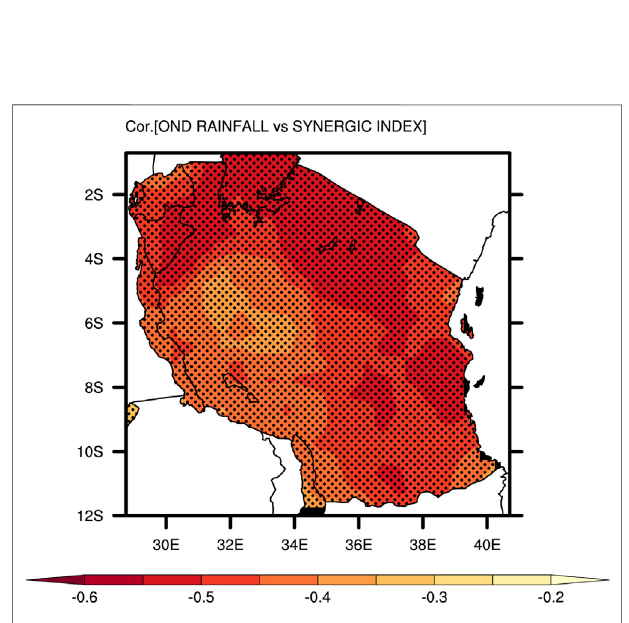
FIGURE 14 | Schematic summary of the process for the impact of warm EA-SST and SA-SST on OND precipitation in Tanzania.